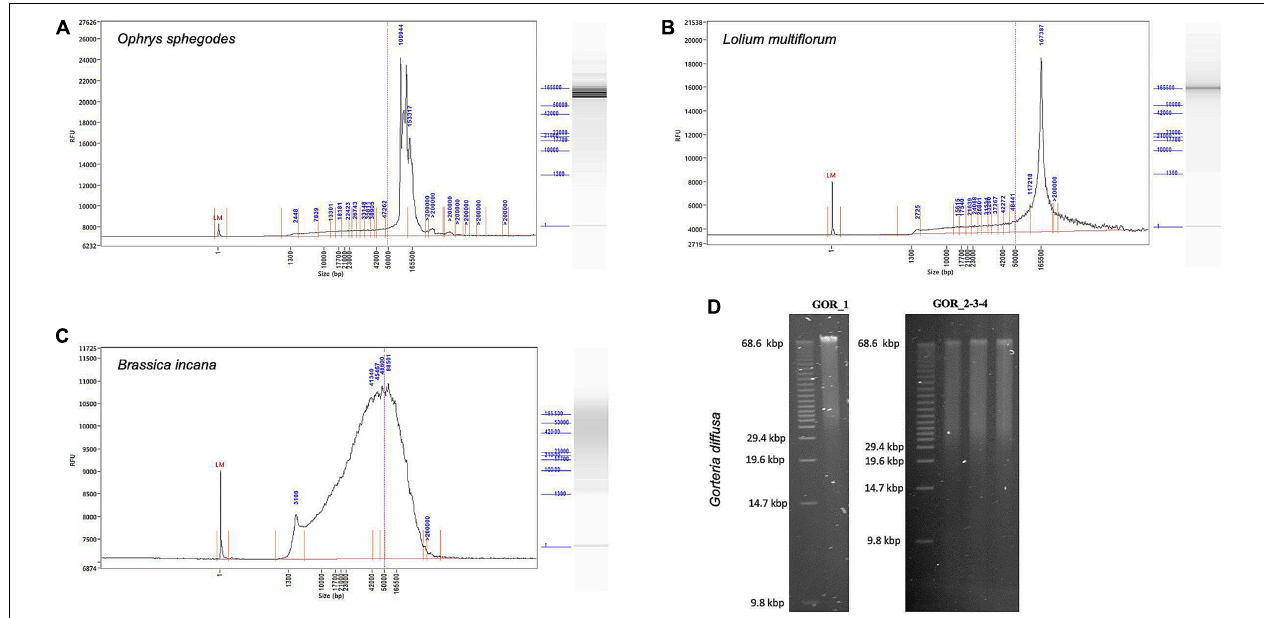
FIGURE 3 | Fragment length profiles of extracted HMW DNA. (A–C) Femto Pulse profiles showing integrity and size of gDNA. (A) O. sphegodes sample OPH_3 with peaks at 110 and 153 kbp. (B) L. multiflorum (sample RAB_2) with a peak at 167 kbp. (C) B. incana (sample BRI_1) showing a broader fragment size distribution centred at 50 kbp. (D) Gel pictures for G. diffusa DNA extracts (GOR_1-4, from a pool of two initial extractions).